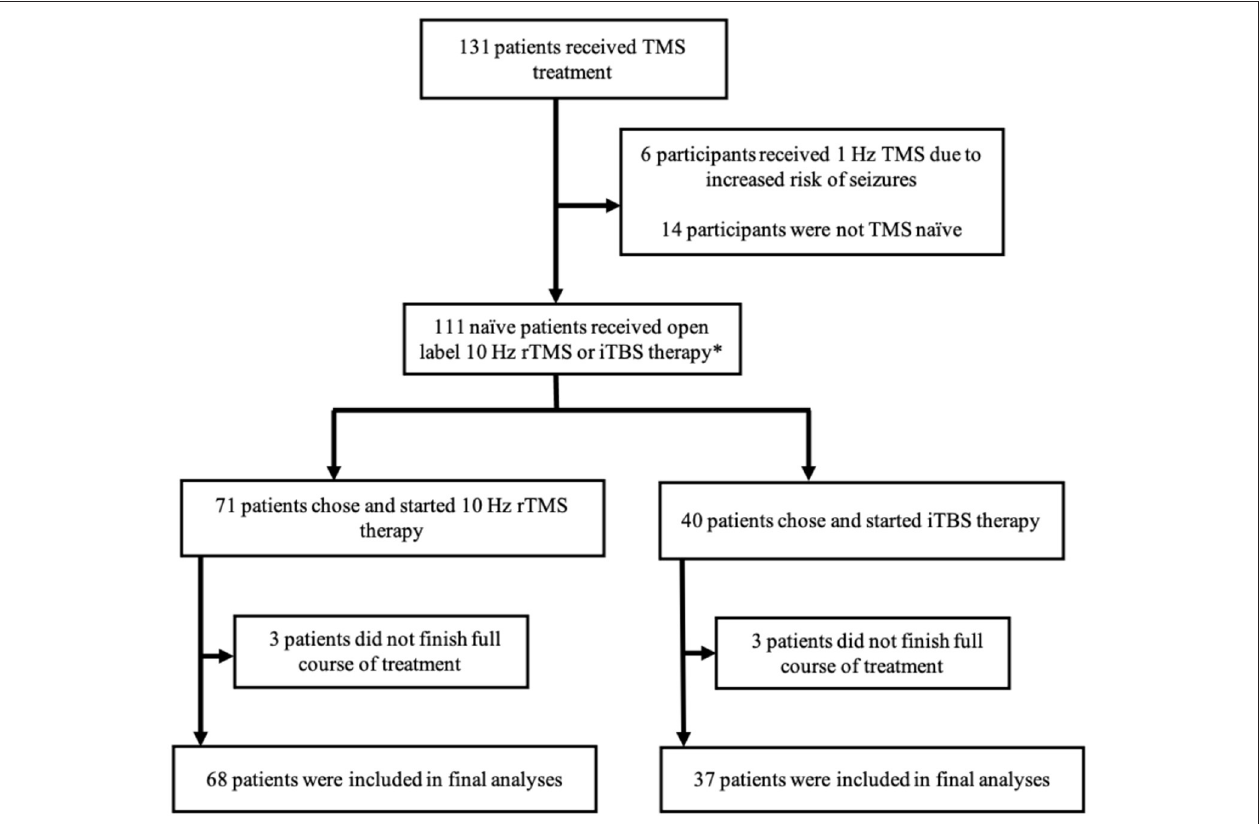
FIGURE 1 | Summary of study participant disposition. A graphical depiction of the various outcomes and participation status of the study participants. TMS, transcranial magnetic stimulation; rTMS, repetitive transcranial magnetic stimulation; iTBS, intermittent theta burst stimulation. *Prior to FDA clearance of iTBS in 2018, participants mainly received 10Hz rTMS. After the FDA clearance, participants were able to choose between 10Hz rTMS and iTBS therapy.